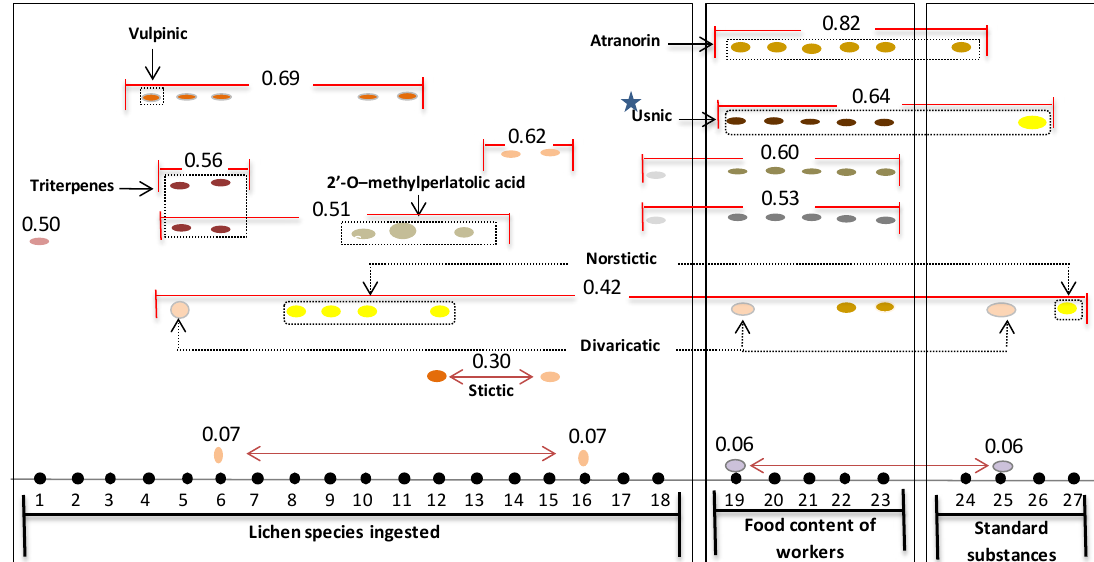
Fig 2. Thin layer chromatography of lichens organic extracts ingested by Constrictotermes cyphergaster and crop food content of workers during foraging in dry season (2012) in a semiarid region of northeastern Brazil. Chromatography points: 1-18: (Lichens): 1- Anisomeridium subprostans ; 2- A. tamarindi ; 3- Arthopyrenia cinchonae; 4- Chrysotrix xanthina ; 5- Dirinaria confluens ; 6- D. leopoldii ; 7- Glyphis scyphulifera ; 8- Graphis submarginata ; 9- Graphis sp.; 10- Lecanora achroa ; 11- L. helva ; 12- Leucodecton occultum ; 13- Opegrapha cf. arengae ; 14- Pertusaria flavens ; 15- P. quassiae ; 16- Pertusaria sp.; 17 - Polymeridium proponens ; 18- Pyrenula anomala . 19 to 23: (Craw food content of workers who ate lichens): 19- Nest Population 1; 20 - Nest Population 2; 21- Nest Population 3; 22- Nest Population 4; 23- Nest Population 5. 24-27: (Standard substances): 24- Atranorin; 25- Divaricatic acid; 26- Usnic acid; 27- Nortistic acid.